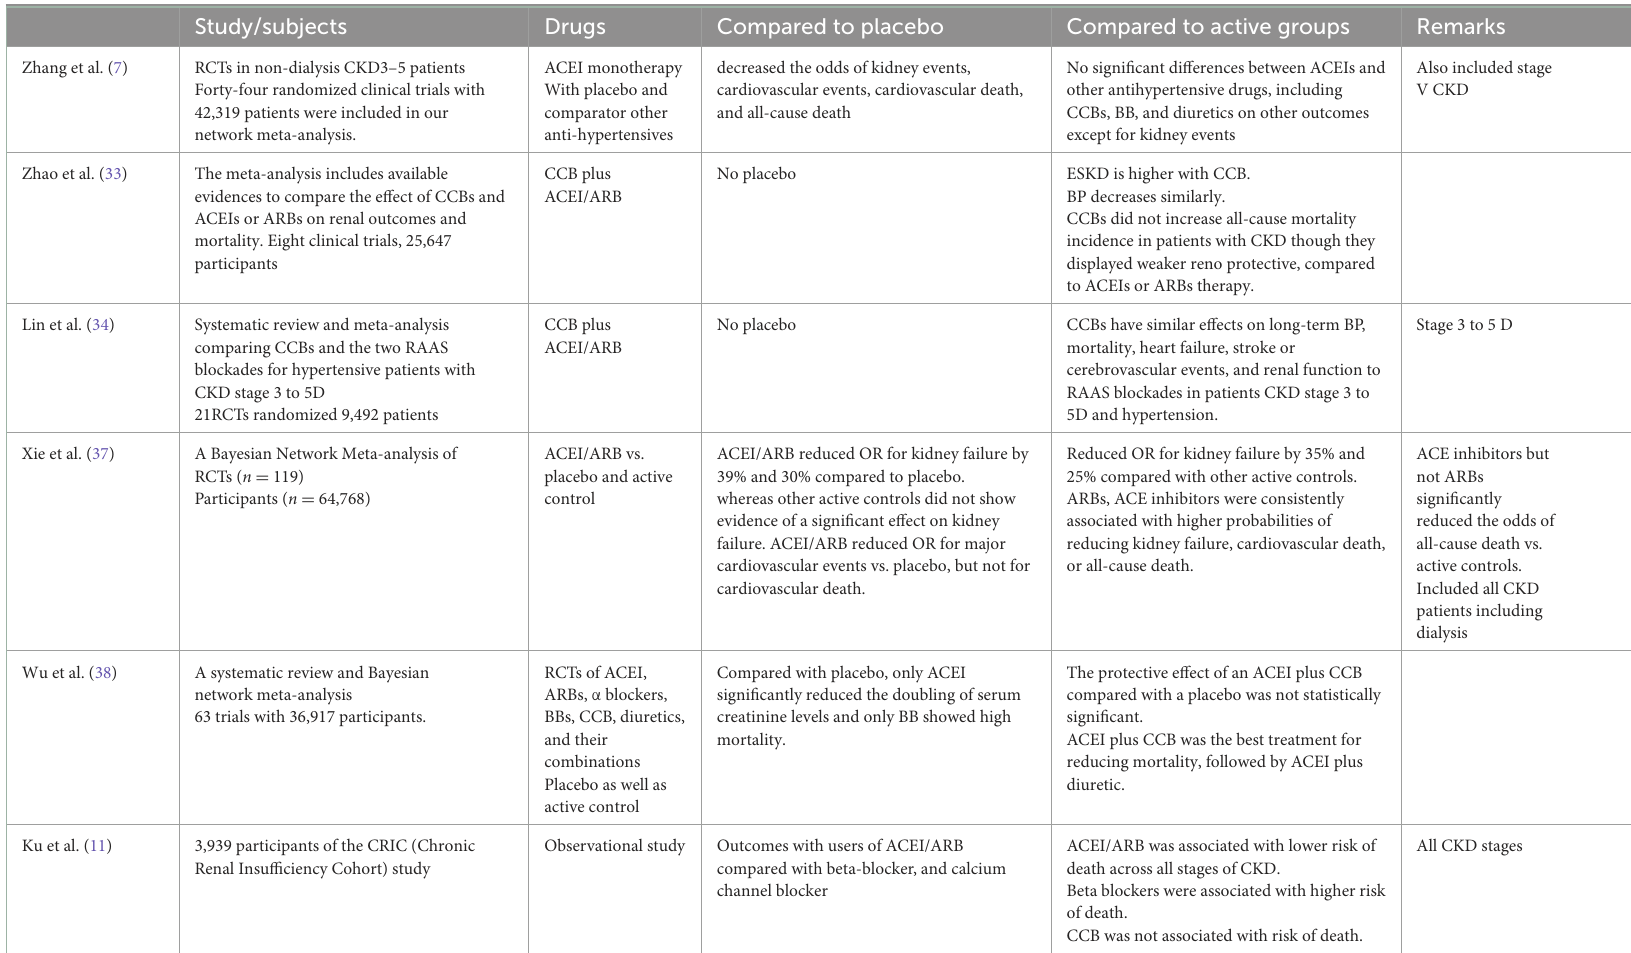
TABLE 5 Major systematic review and randomized study which compared ACEI/ARB against placebo or active control population with other